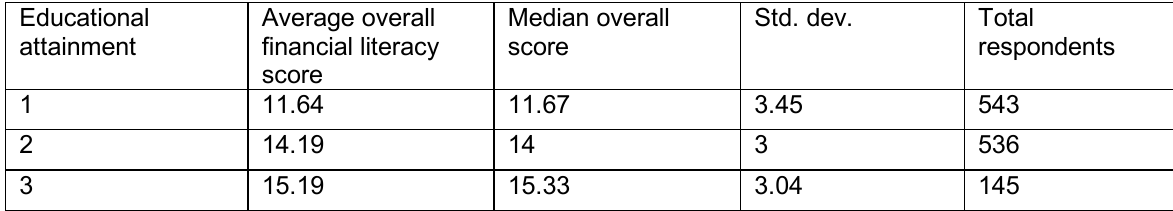
Figure 3: Financial Literacy Segments by Education Table 10: Frequency Distribution of The Number of High Scores of The Respondents by Gender